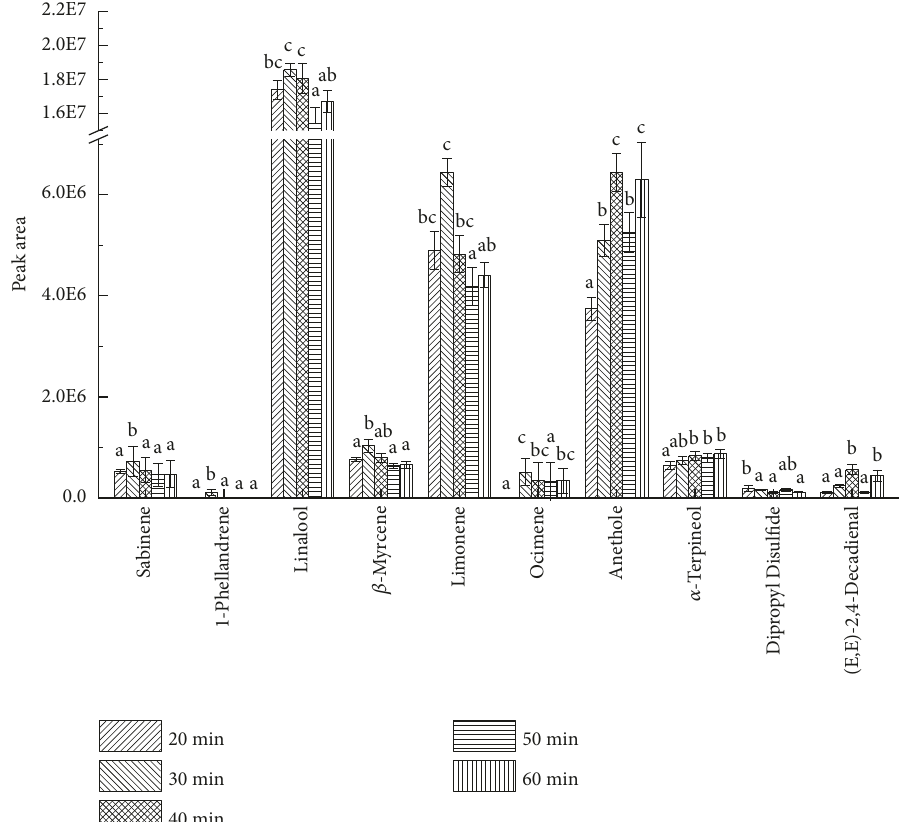
Figure 9: Effects of extraction time on peak areas of key volatile compounds. English letters “a”, “b”, “c” indicate Duncan’s multiple range test among peak areas of the five extraction times. Data in the same compound marked with different letters mean significant difference ( p < 0.05) and the same letters denote not significant difference (p < 0.05).